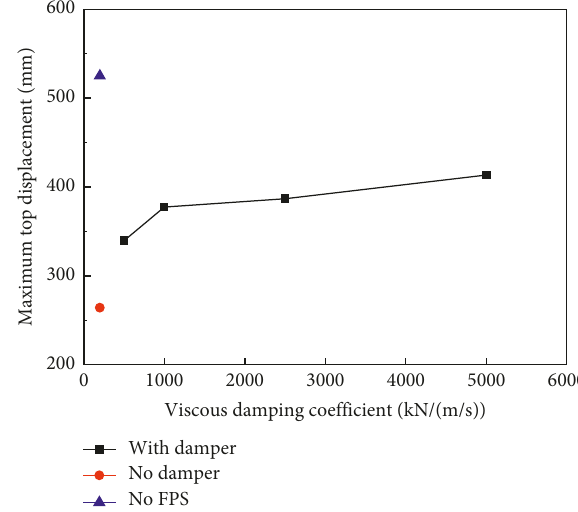
Figure 26: The maximum top displacement of T4S tower with R and μ in the Y direction under L6501S wave.